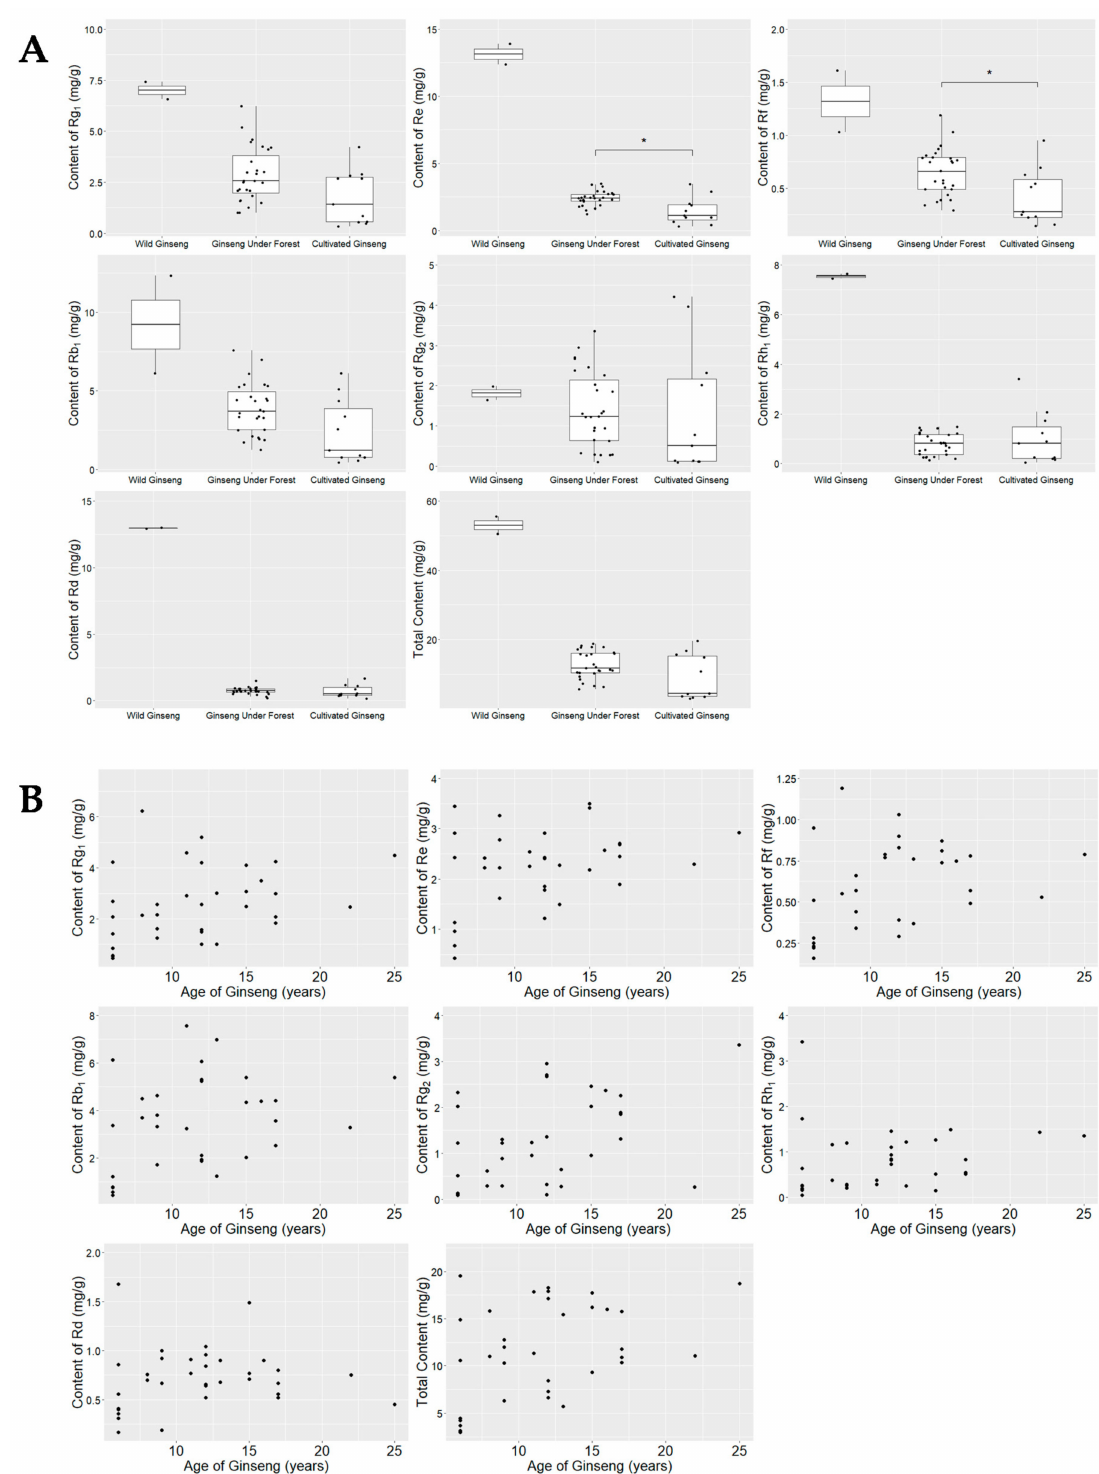
Figure 4. Comparison of the contents of seven ginsenosides and their total content in different types of ginseng samples using t -test (( A ); wild ginseng n = 2, ginseng under forest n = 27, cultivated ginseng n = 11; * p < 0.05), and the scattered plots for contents of the seven ginsenosides and their total content in ginseng under forest and cultivated ginseng with certain growing ages (( B ); n = 34; contents of the seven ginsenosides in six samples—nos. 18, 19, 36–39 were not plotted due to the uncertainty of growing